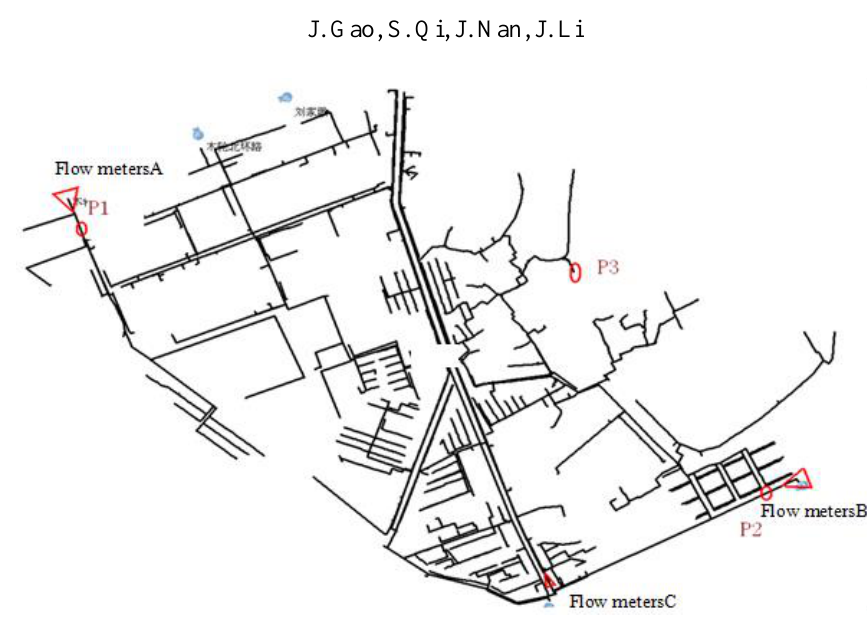
Fig. 6. Network Topology of Metering Area